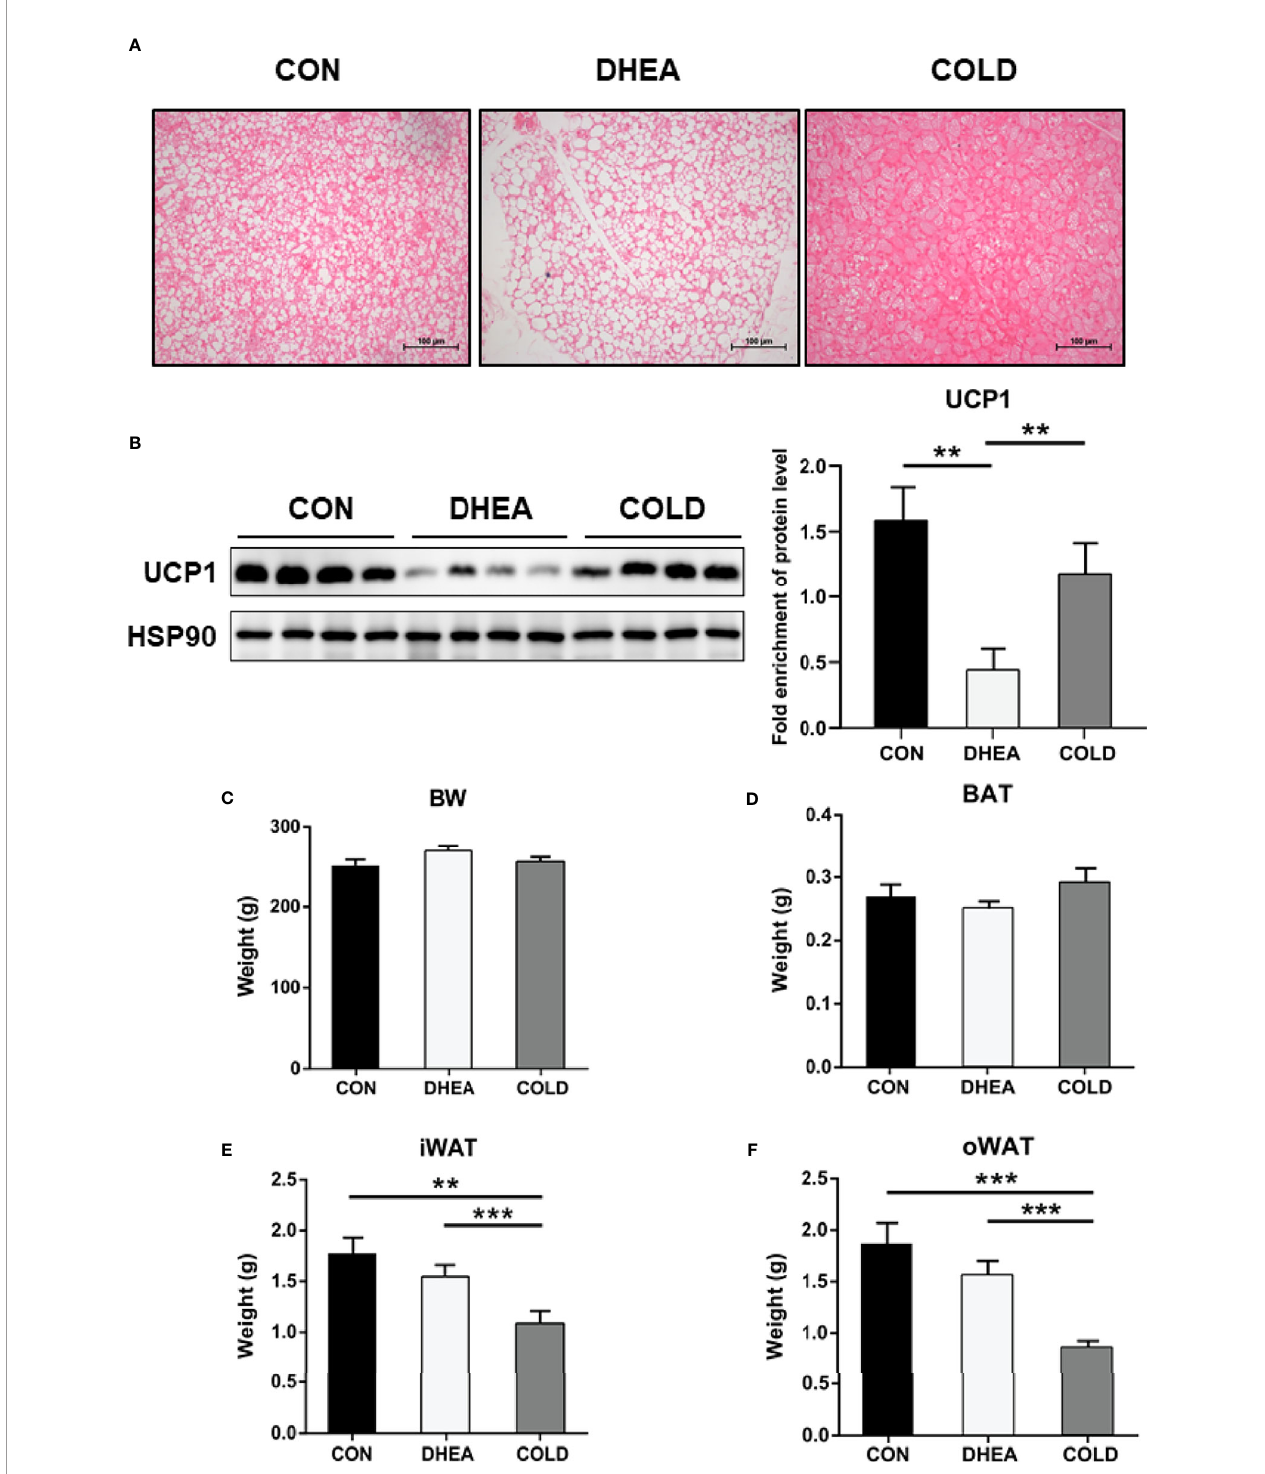
FIGURE 1 | Cold treatment improved activity of BAT in PCOS rat. (A) H&E staining of BAT. Scale bar: 100 m m. (B) Protein expression of UCP1 in BAT. The weight of body (C) , BAT (D) , iWAT (E) and oWAT (F) . Data are means ± SEM. (A) n = 3/group; (B) n = 4/group; (C – F) CON and DHEA treatment (n = 10/group), and COLD treatment (12 = 10/group). One-way ANOVA with Tukey post-hoc test was used to compare groups. ** P < 0.01, *** P <